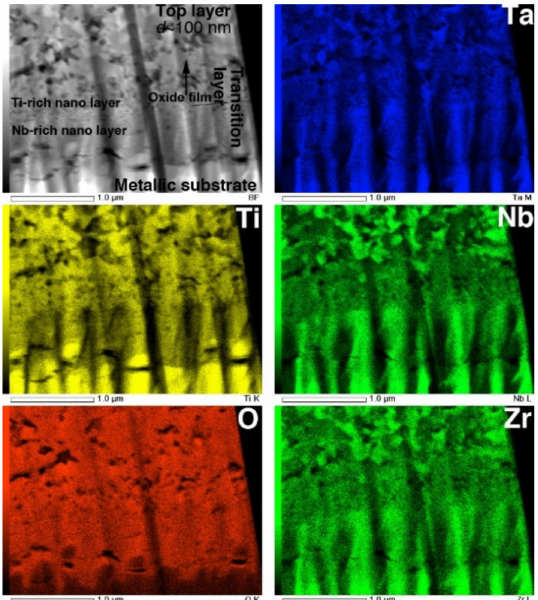
Figure 12. STEM image and EDS composition maps of Ti, O, Nb, Ta, and Zr in cross-section of interface of oxidized Ti–29Nb–13Ta–4.6Zr. The oxidation conditions at 1273 K for 1.8 ks in air. The STEM and EDS mapping images of an equiaxed oxide layer are shown in Figure 13. These composition maps suggest that the oxide layer consists of multiple phases. Phase separation into Ti-rich grains and Nb-, Ta-, and Zr-rich grains was identified. According to the XRD profile, the Ti-rich grains are likely TiO 2 , while the Nb- and Ta-rich grains are likely TiNb 2 O 7 or Ti(Nb, Ta) 2 O 7 . Although Zr is generally recognized as being a neutral element with respect to β stabilization [2], the concentration of Zr atoms in the oxide-containing Nb and Ta was high compared to Ti-rich grains. These equiaxed submicron grains were homogeneously dispersed with TiO 2 grains, and the grain diameters were 100–200 nm. These results indicate that both oxides grow almost simultaneously.